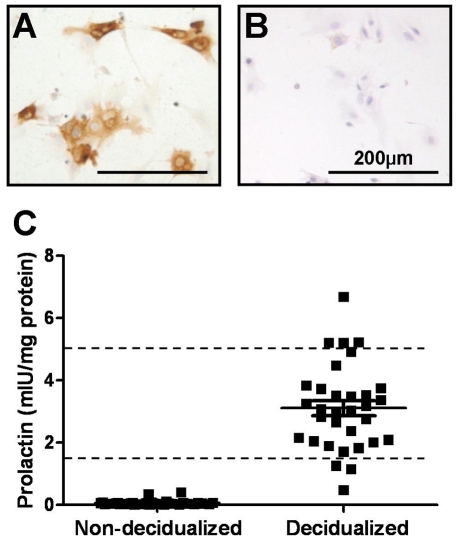
Purity of isolated extravillous trophoblast (EVT) and prolactin secretion by human endometrial stromal cells following decidualization treatment.A. HLAG immunolocalization in isolated EVT. B. Negative (IgG) control for isolated EVT. C. Prolactin secretion by human endometrial stromal cells induced to decidualize in vitro (estrogen [10−8 M], medroxyprogesterone acetate [10−7 M] and cyclic adenosine monophosphate [0.5 mM]) for 2 (non-decidualized) and 14 (decidualized) days. Conditioned media from decidualized samples containing <1.5 mIU/mg or >5 mIU/mg prolactin (dotted line) were excluded from further studies.